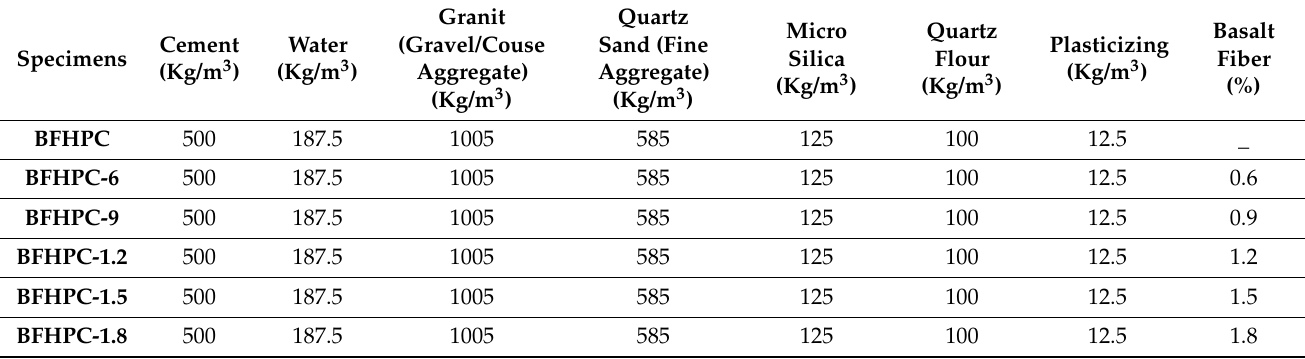
Table 4. Concrete mix properties.